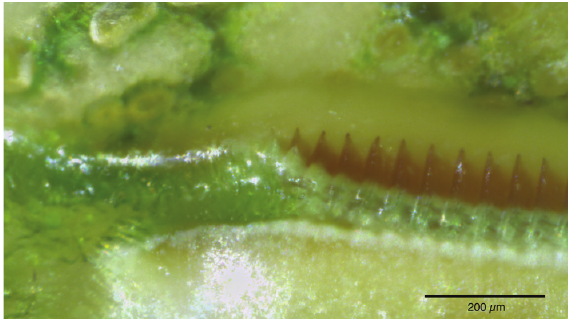
Figure 18. Detail of stridulatory file of Gonatoxia immaculata with teeth directed towards the anal end.